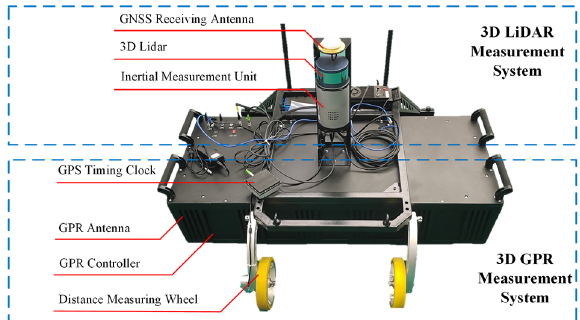
Figure 4. the integrated ground and under-ground 3D surveying